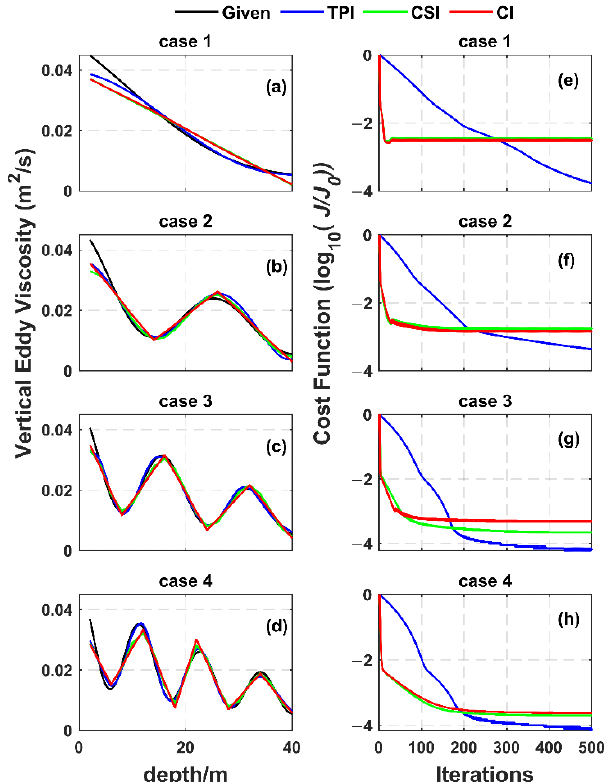
Figure 1. On the left are the prescribed and inverted VEVCs obtained by different interpolation schemes in the model. Panels ( a – d ) correspond to Cases 1–4, respectively. On the right are the variation curves of the cost functions in Group 1. Panels ( e – h ) correspond to Cases 1–4, respectively.